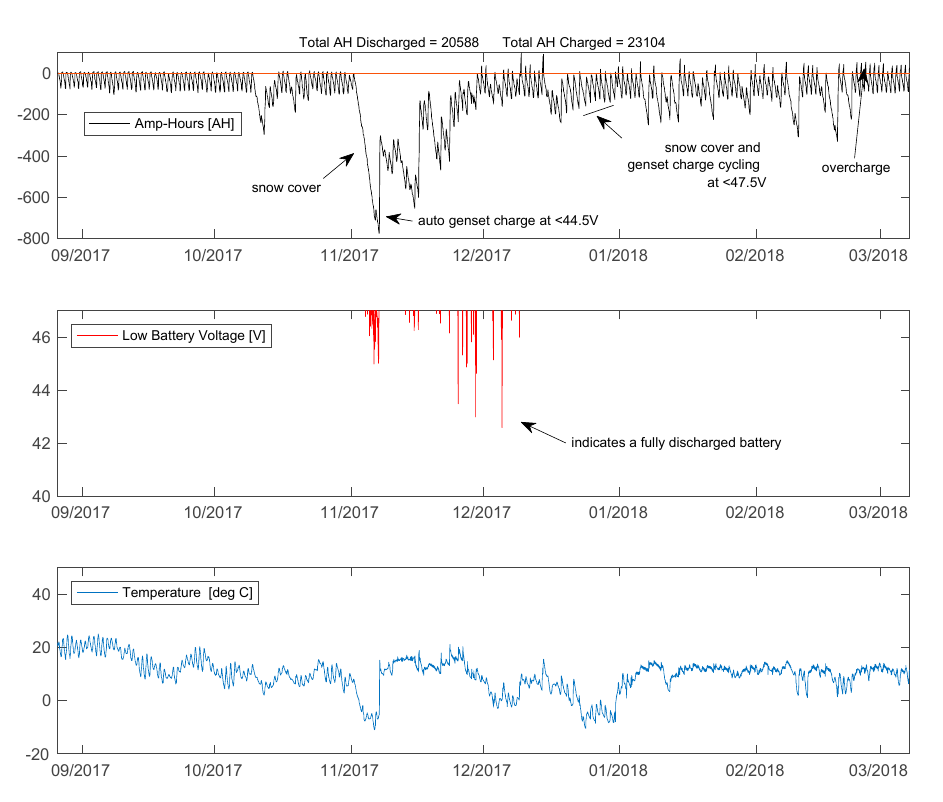
Figure3. Figure 3. Six months of battery operation detailing a severe loss of capacity and subsequent battery recovery.